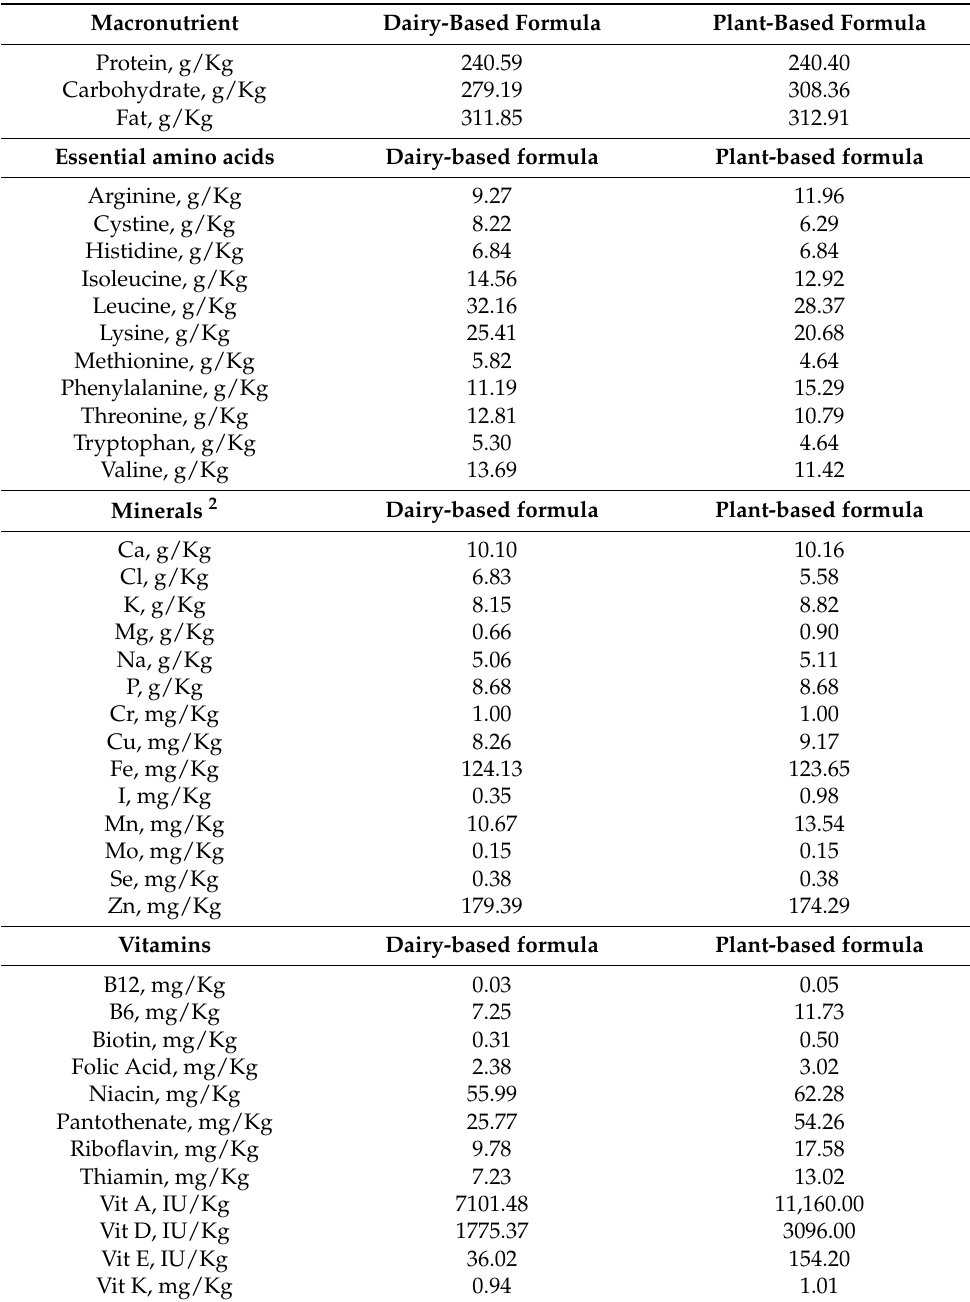
Table 1. List of calculated nutrients for the dairy-based (Similac Advance powder) and plant-based formula (Else Nutrition powder) fed to piglets 1 ( n = 9/group) from postnatal day (PND) 2 until PND 21. Additional information on the diet’s formulation can be found in Supplemental Table